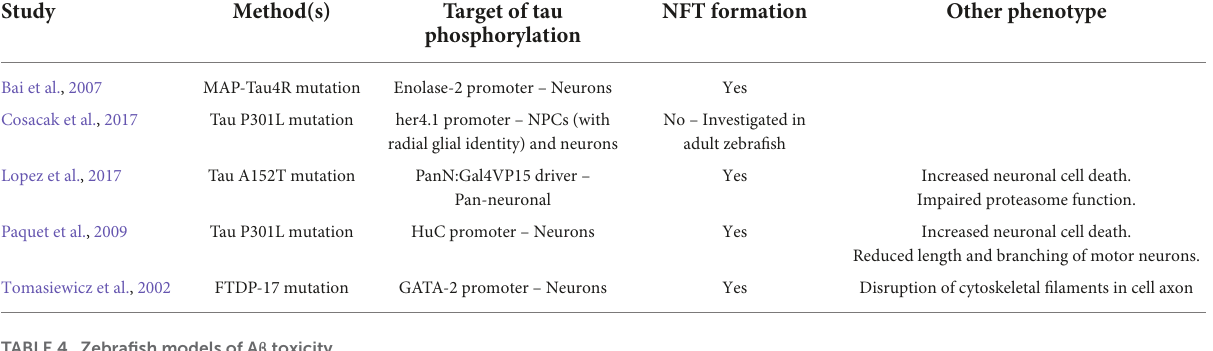
TABLE 4 Zebrafish models of A β